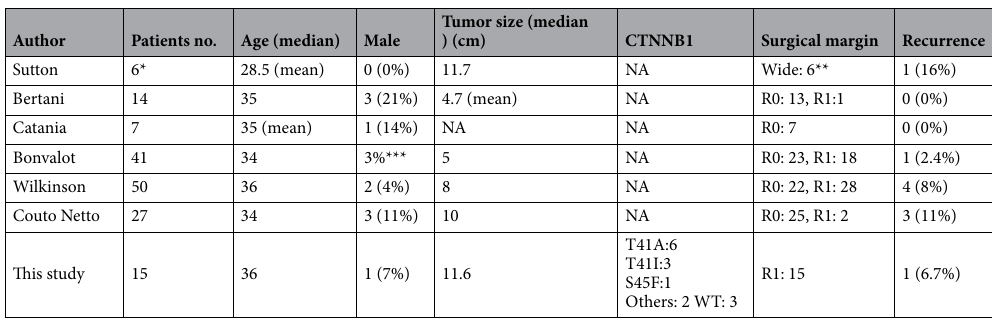
Table 4. Studies reporting results of abdominal wall desmoid with surgery. *One case with FAP-related desmoid excluded. **Information for microscopic margin not provided. ***Actual number is unclear. All cohort (147 cases) ratio. NA not